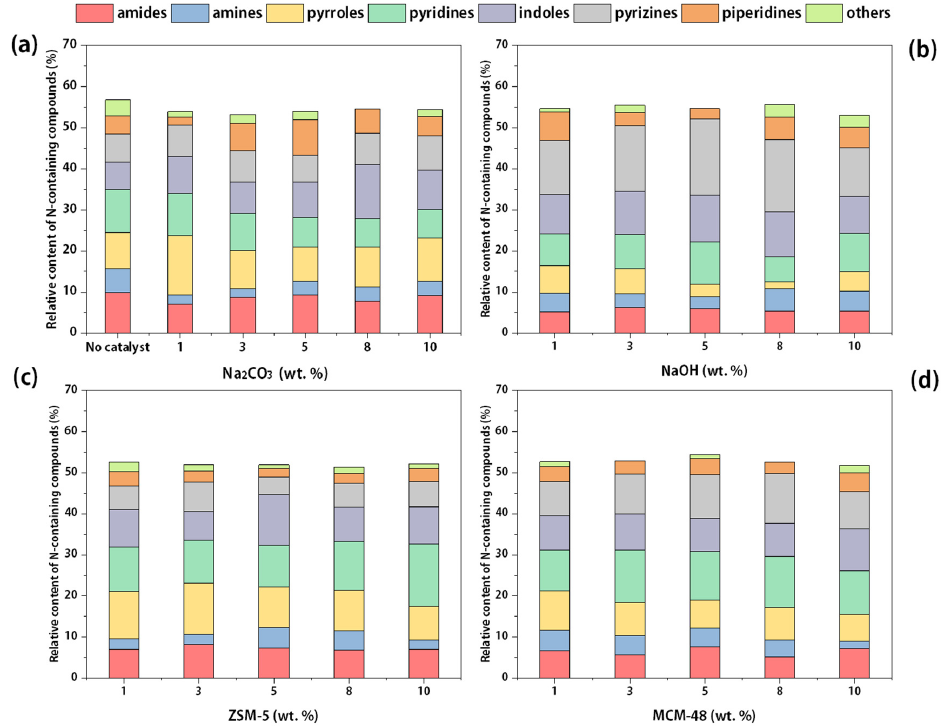
Figure 6. Nitrogen-containing compound distribution of PR bio-oil: ( a ) Na 2 CO 3 , ( b ) NaOH, ( c ) ZSM-5, ( d ) MCM-48. The formation of nitrogen-containing compounds in bio-oil might be related to the decomposition of protein N (protein and amino acid) in PR. The hydrolysis of proteins produced nitrogen-containing components such as amides, amines and nitrogen-contain- ing heterocyclic compounds. Fatty acids produced by lipid decomposition react with NH 2 /NH 3 to form aliphatic amides [29] such as dodecanamide, hexadecanamide and stea- ric amide (as (Z)-9-octadecenamide, N-methyl-1-octadecanamine and N-butyl octade- canamide). The addition of catalysts could reduce the content of amides and amines. In homogeneous and heterogeneous catalysts, when NaOH and MCM-48 were added at 10% and 8%, the amide content decreased to 5.29% and 5.19%, respectively; when the addition of Na 2 CO 3 and MCM-48 was at 3% and 10%, the amine content decreased to 2.17% and 1.83%, respectively. Amino acids and carbohydrate derivatives in PR could form nitrogen-containing het- erocyclic components such as pyrrole, pyridine and pyrazine through Maillard reactions [30]. Indole could be formed by dehydrogenation, decarboxylation or cyclization of aro- matic amino acids (phenylalanine and tyrosine) in bacterial residue [31]. The total content of nitrogen-containing heterocyclic compounds (pyrrole, pyridine, indole, pyrazine and piperidine) in the catalytic bio-oil increased significantly in this study. Compared with non-catalytic bio-oil (41%), the proportion of nitrogen-containing heterocyclic compounds in catalytic bio-oil increased to 44.6% (Na 2 CO 3 , 1 wt.%), 45.9% (NaOH, 5 wt.%), 43.03% (ZSM-5, 1 wt.%) and 43.41% (MCM-48, 8 wt.%). There were some other nitrogen-contain- ing compounds in bio-oil, including 3-benzyl-6-isopropyl-2,5-piperazinedione, 3,6-Diiso- propyl-2,5-piperazinedione and 2,4,6-trimethyl-benzonitrile. The former two compounds belong to 2,5-piperazinedione compounds and could be produced by dehydration and condensation of amino acids [31], which were an important intermediate product of the hydrothermal liquefaction of PR. According to Chen et al. [32], the conversion of nitrogen-